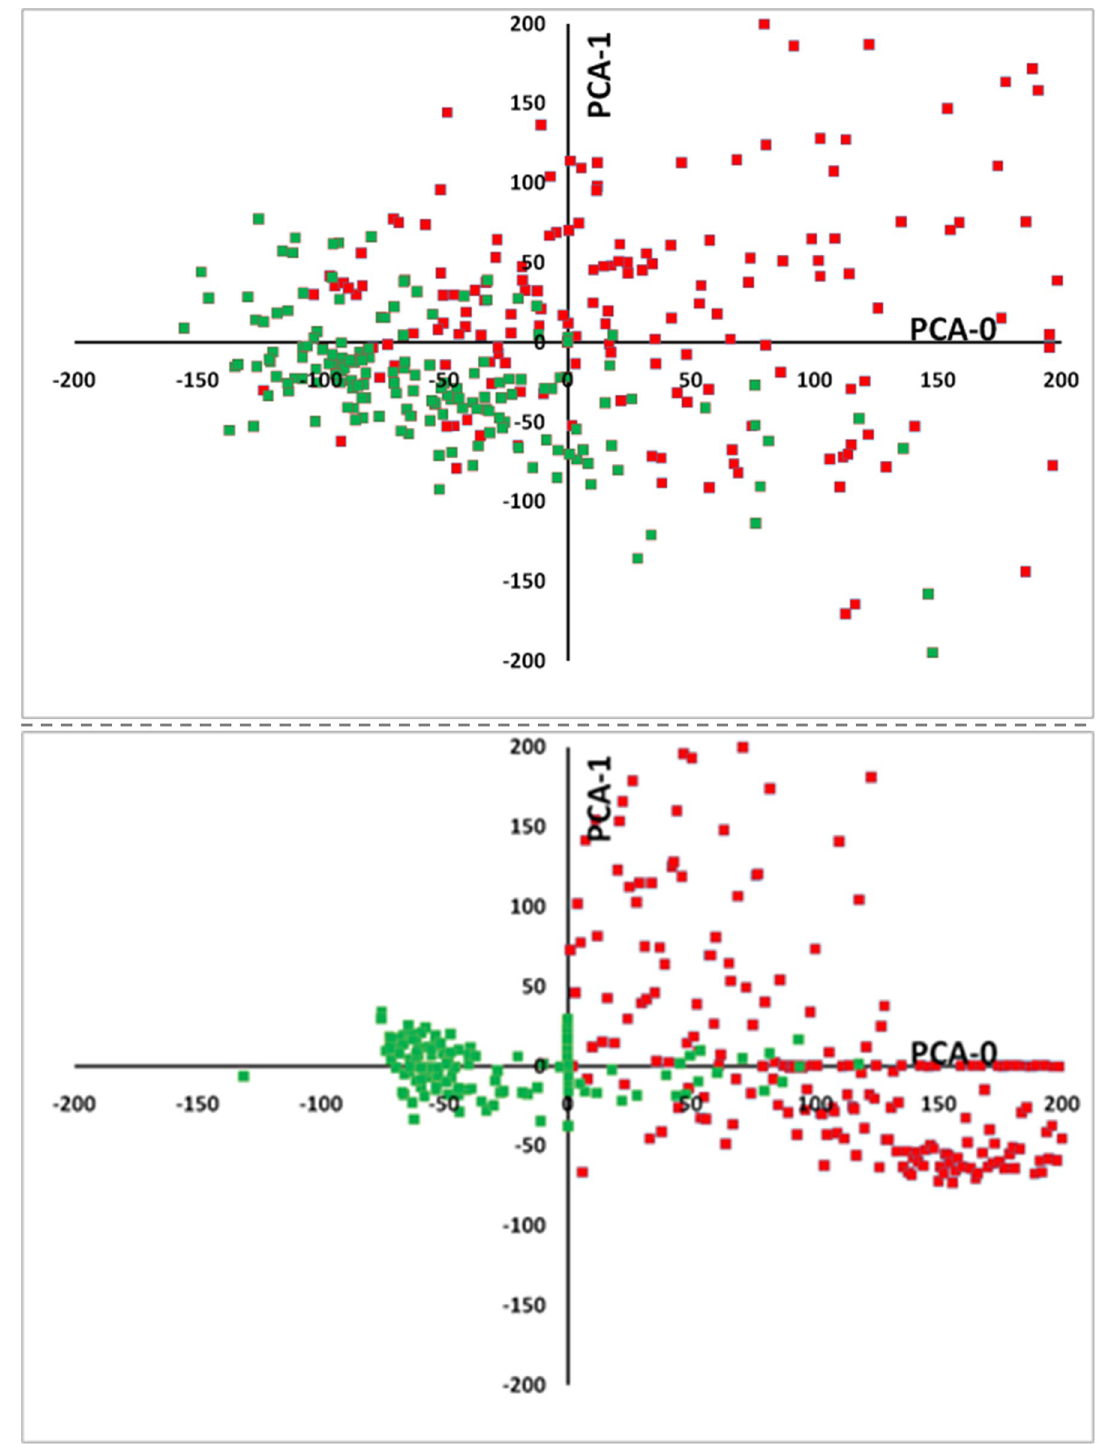
Fig 3. Two-dimensional plots showing two main principal components. In the upper graph, five input features (LDL, HDL, TG, TC and Age) were calculated for subjects with diabetes (red squares) compared to all control subjects (green squares). In the lower graph, two input features (FBS and Age) were calculated for all subjects with dyslipidemia (red squares) compared to all control subjects (green squares). The clinical parameters used to define the diseases (lipid profile for dyslipidemia, and FBS for T2DM) were excluded from the input data as described